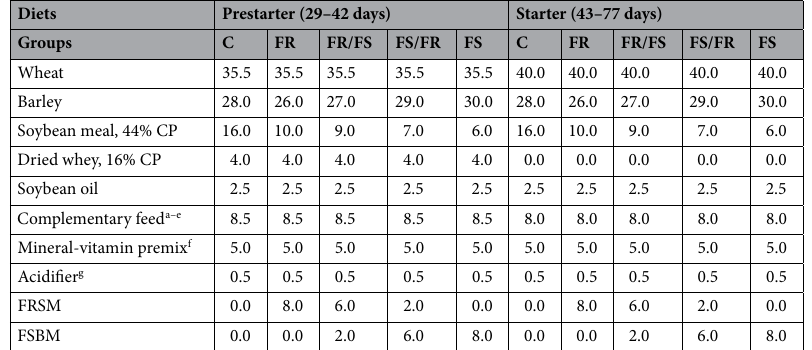
Table 6. Ingredient composition (% of air-dry matter) of piglet diets 10 . C control, FR group receiving a diet with 8% FRSM, FR/FS group receiving a diet with 6% FRSM and 2% FSBM, FS/FR group receiving a diet with 6% FSBM and 2% FRSM, FS group receiving a diet with 8% FSBM. a Complementary feed, 1 kg (control group) containing crude protein 36.15%, lysine 2.50%, methionine 0.73%, crude fat 14.3%, crude fibre 2.85%, calcium 1.2%, phosphorus 0.85%, sodium 0.35%, BHT 280 mg. b Complementary feed, 1 kg (FR group) containing crude protein 36.65%, lysine 2.61%, methionine 0.75%, crude fat 14.6%, crude fibre 2.75%, calcium 1.15%, phosphorus 0.84%, sodium 0.33%, BHT 280 mg. c Complementary feed, 1 kg (FR/FS group)